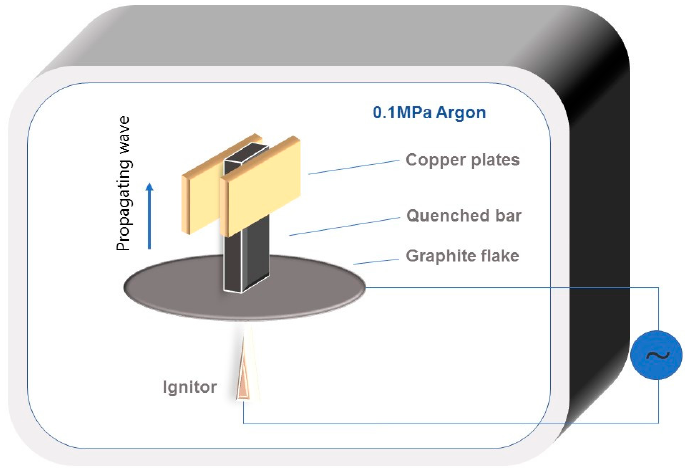
Figure 2. The schematic diagram of the combustion wave quenching experimental device.